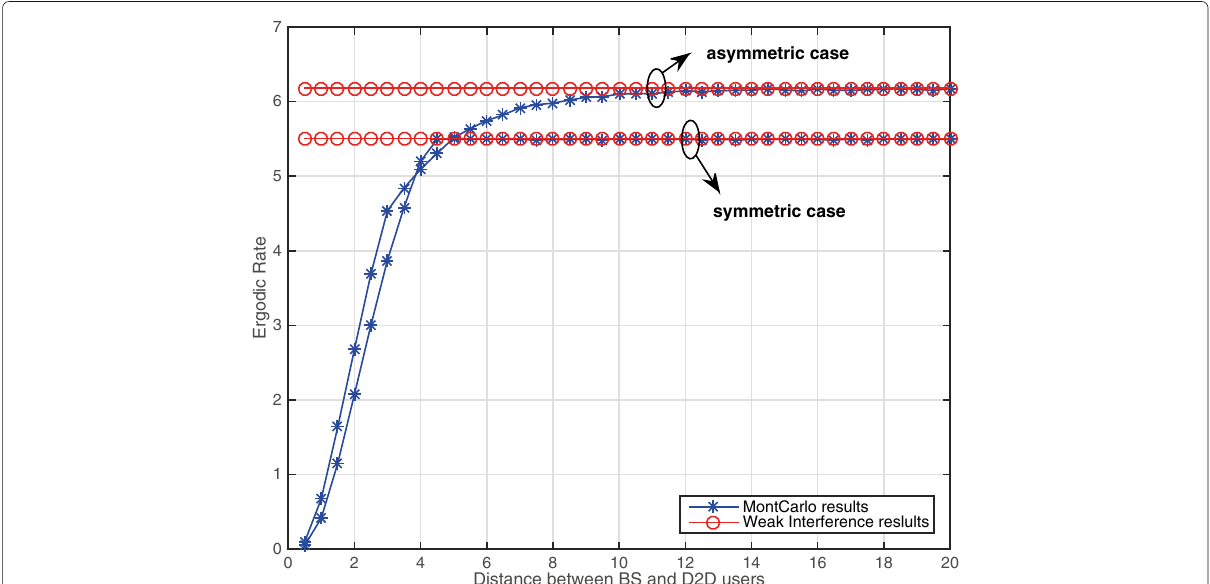
Fig. 5 Weak interference approximations and Monte-Carlo simulated ergodic rate against the distance between BS and D2D users for both asymmetric and symmetric cases